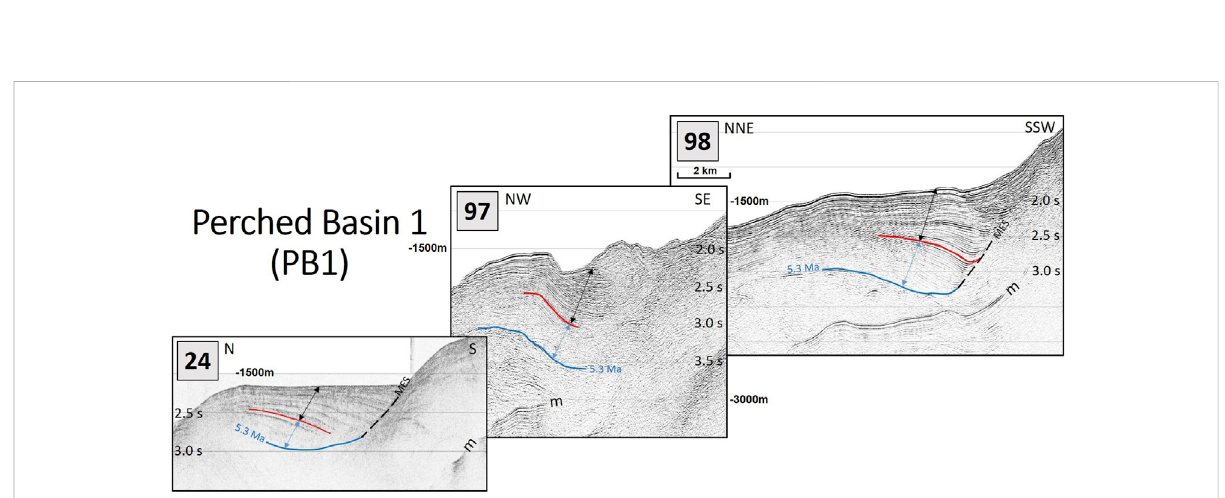
FIGURE 8 Two-waytraveltimeseismicsections(zooms)24,97,98fromwesttoeastoffBoumerdès,displayinggrowthstratabelowtheperchedsurfaces PS1. Zooms are located on Figure 2. Double black arrows: sedimentary unit interpreted as growth strata (wedges), assumed to be synchronous to tectonic inversion by thrust ramps. Double blue arrows: sedimentary unit assumed to be deposited prior to the onset of tectonic inversion. Arrows are placed in order to represent the mean thickness of the depocentres. Red line marks the limit between the two sedimentary units, i.e. time when tectonic deformation began. Faults responsible for growth strata development in the hanging wall are south-dipping blind thrusts and are not imaged here owing to moderate penetration. Spacing between horizontal lines is 500 m two-way travel times. M = fi rst multiple of the sea fl oor. MES=MarginErosionSurface(Lo fi etal.,2011),apolygenicerosionalsurfaceinterpretedtorepresenttheentiretimeintervalofthedrawdownphase of the Messinian Salinity Crisis. See text for